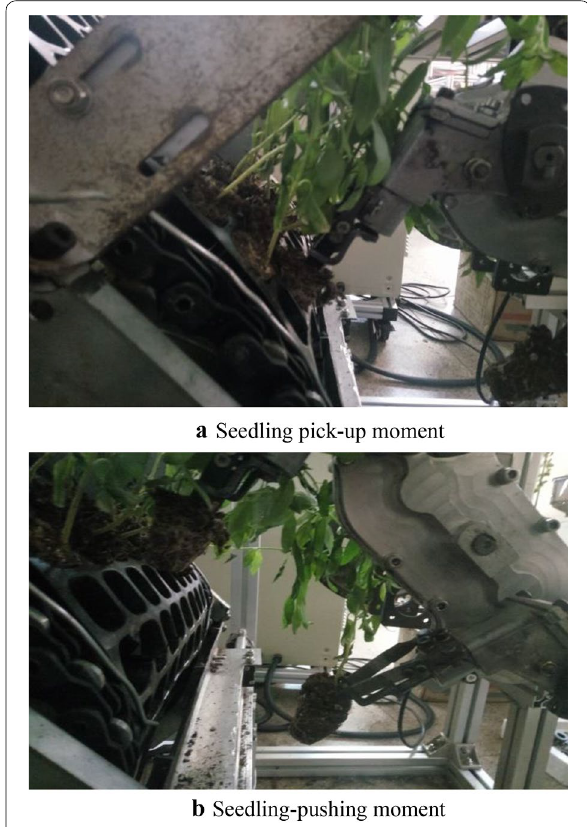
Figure 14 Seedling pick-up tests